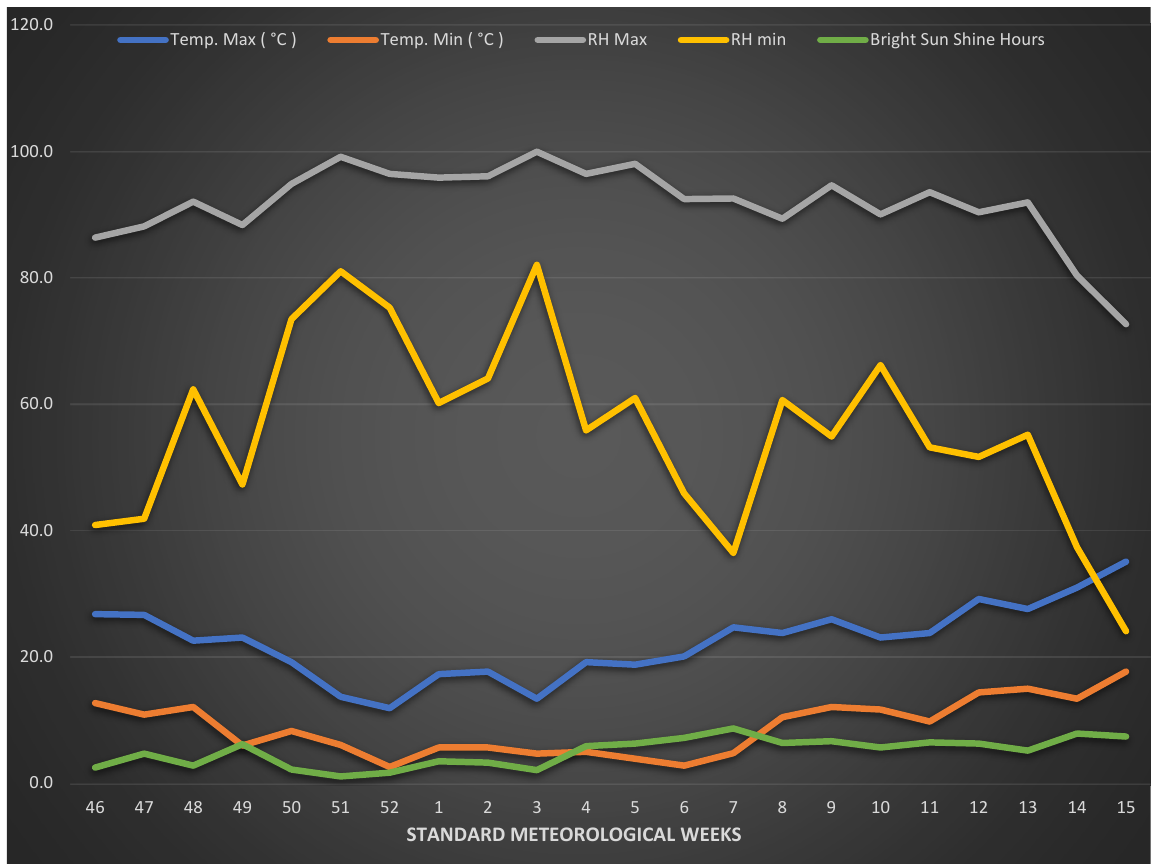
Figure 1. Comparison of weather parameters across two years. Max = maximum temperature; Min = minimum temperature; °C = degree Celsius; mm = millimeter.